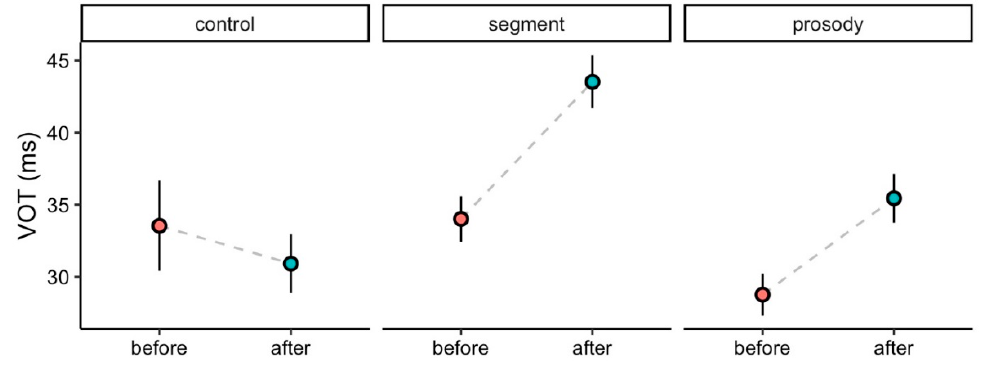
Figure 4. VOT for training groups before and after training (means and standard errors).